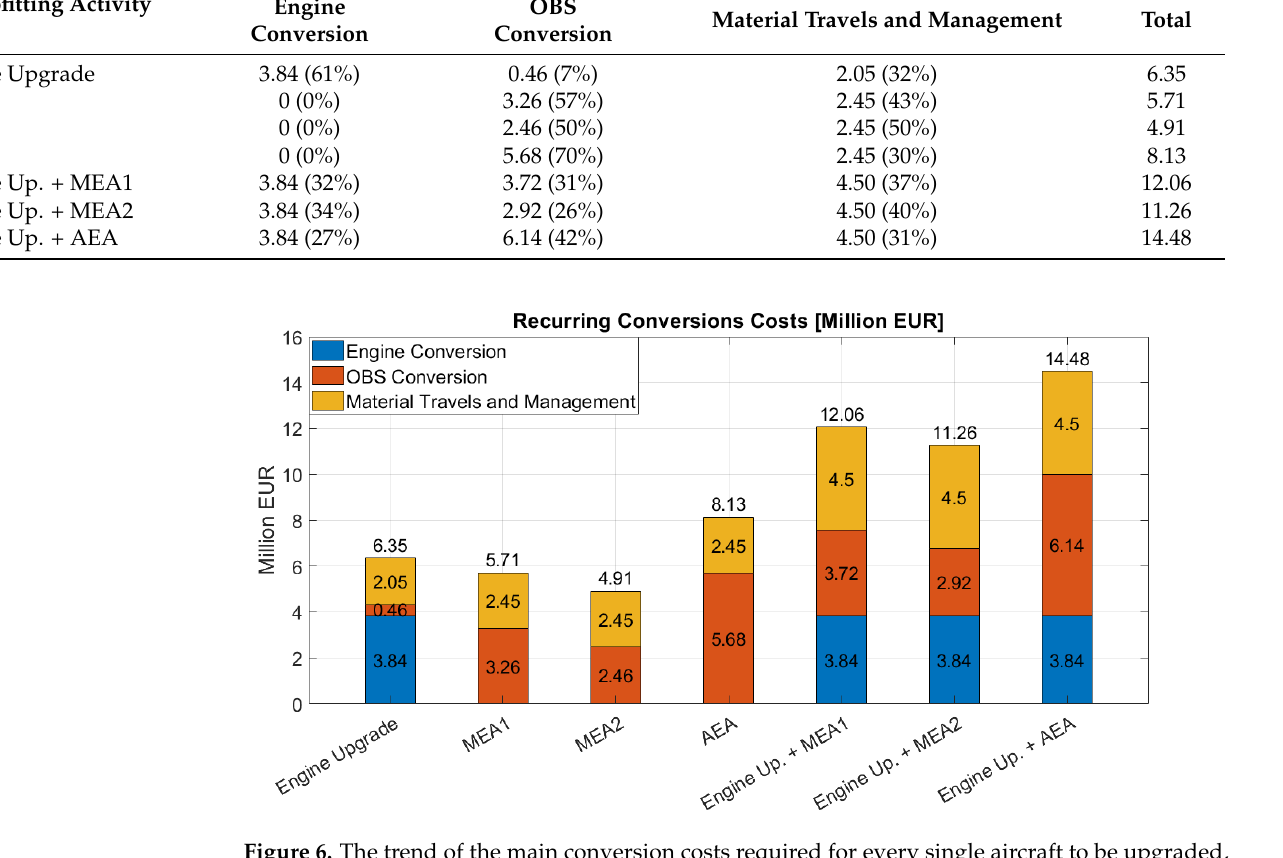
Figure 6. The trend of the main conversion costs required for every single aircraft to be upgraded, computed for seven different retrofitting activities.